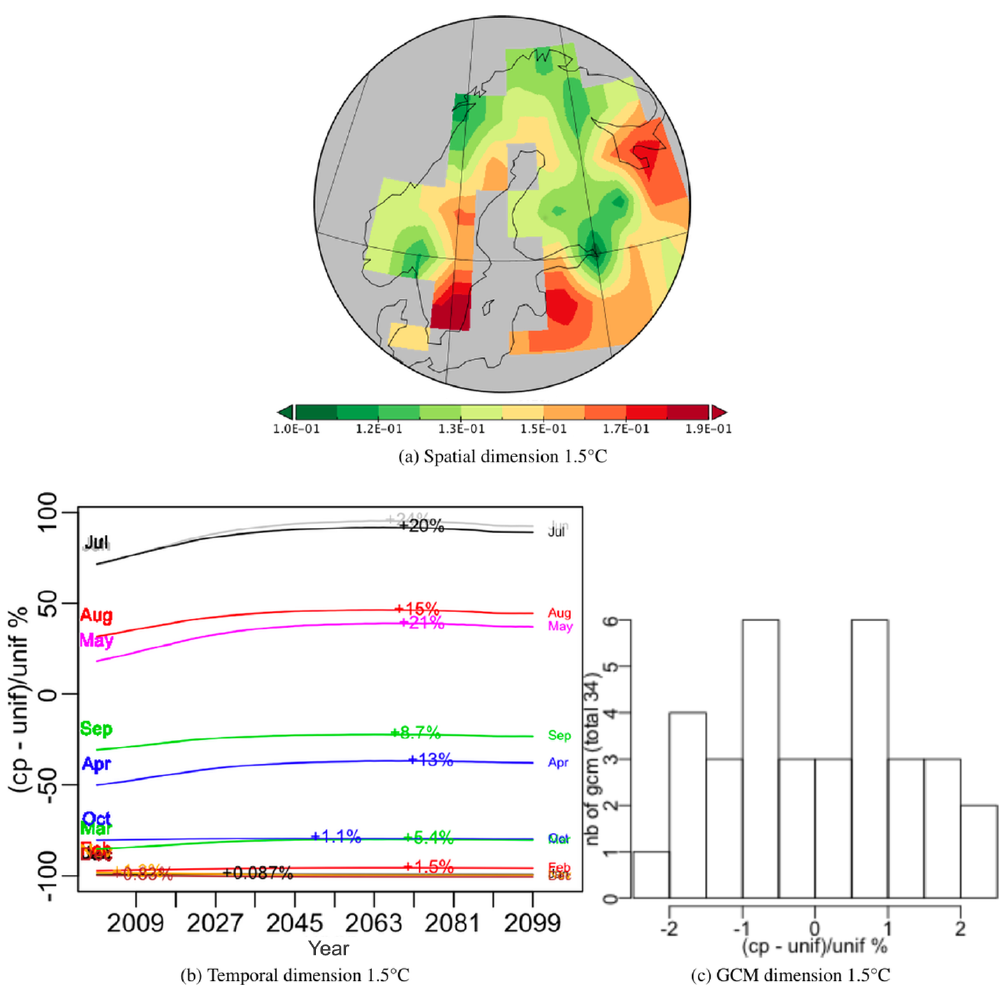
Figure 12. Components of the best principal tensor from the PTA3 analysis of NPP for JULES driven by 34 different GCMs (using IMOGEN) under the + 1 . 5 ◦ C target scenario. For the temporal and GCM dimensions the percentage relative difference from uniform weighting, 100 × ( cp − unif )/ unif, of the component weights is plotted, where “cp” and “unif” refer to component weights and uniform weighting respectively. On the temporal plot the increase for each month between 2000 and the maximum value is indicated as an absolute increase above the 2000 value. The GCM weights are shown as a histogram but individual weights are given in Appendix